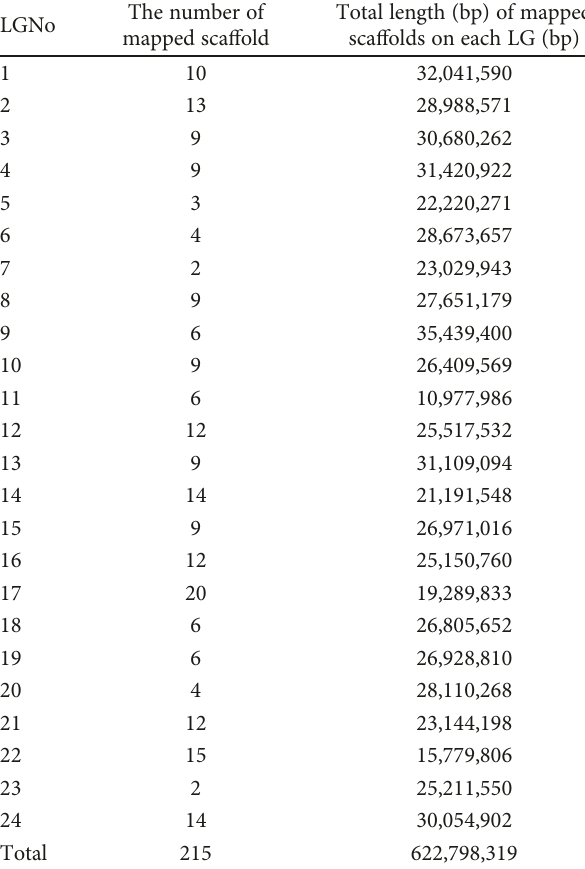
Table 2: Number of mapped sca ff olds and total length of the sca ff olds of greater amberjack mapped to the 24 linkage groups onto yellowtail RH physical map.